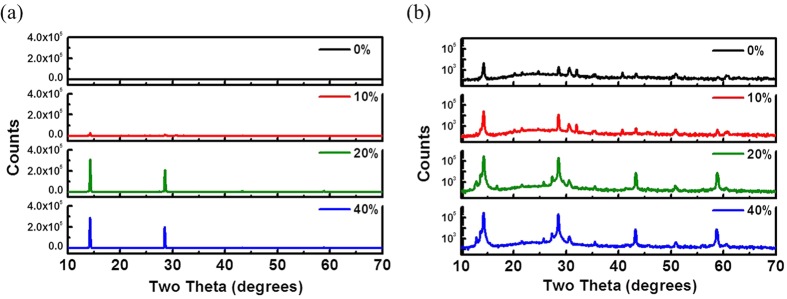
XRD patterns (a) in linear and (b) in logarithmic scale of the CH3NH3PbI3−xClx films prepared with 0, 10, 20 and 40% of chloride, respectively.